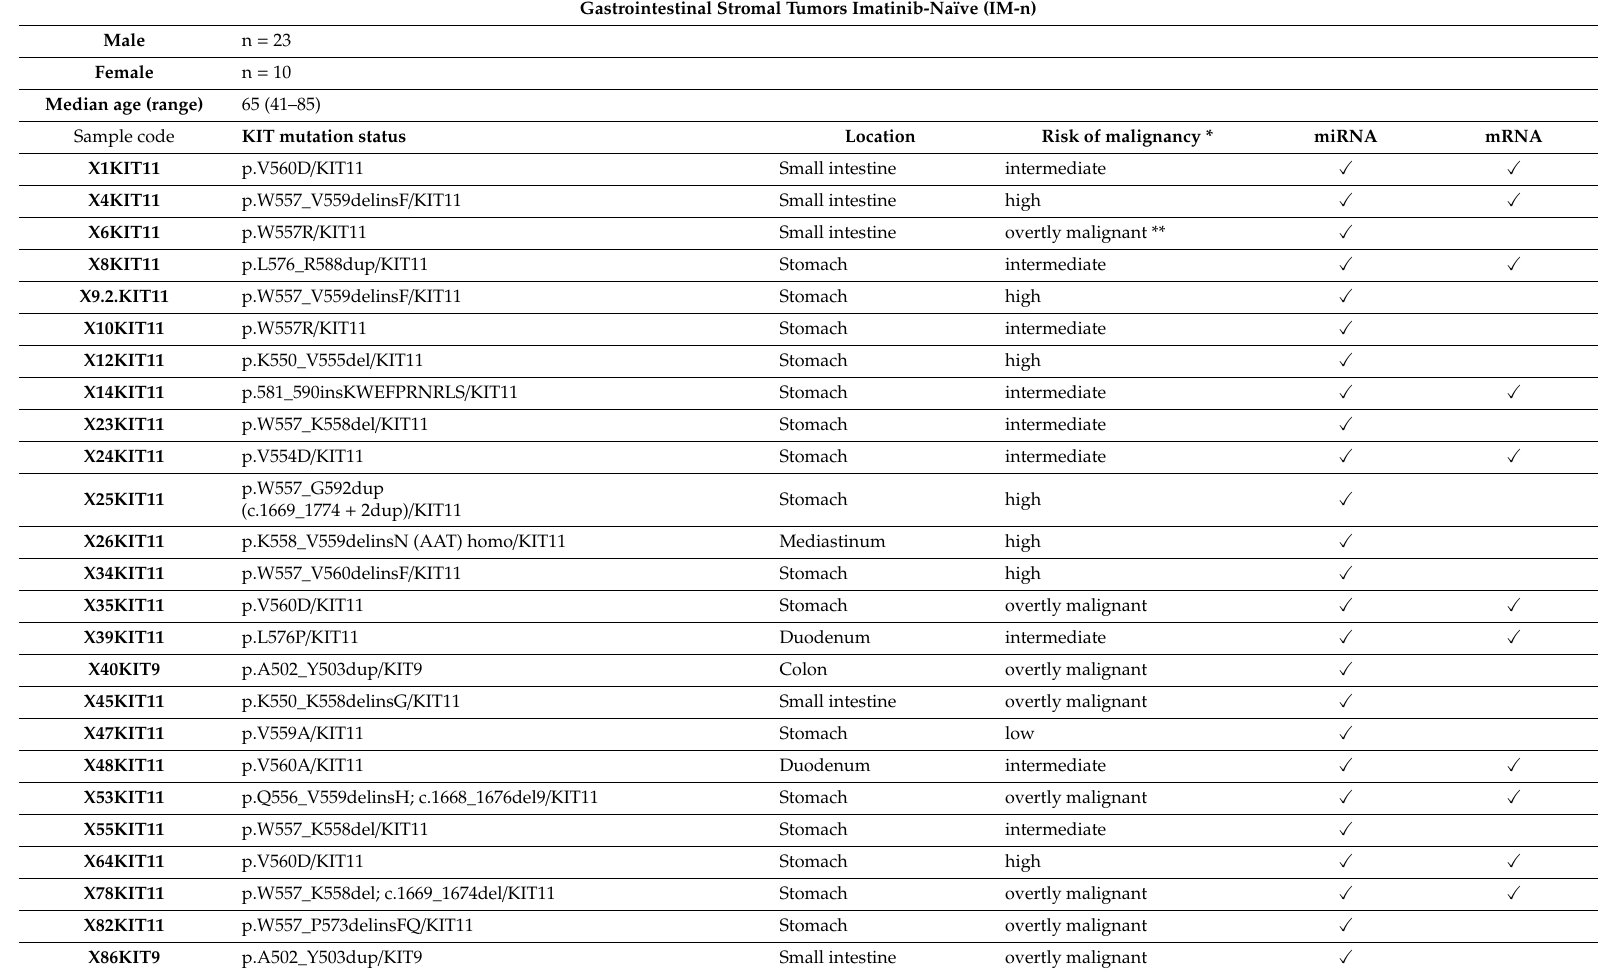
Table 1. Patient and tumor